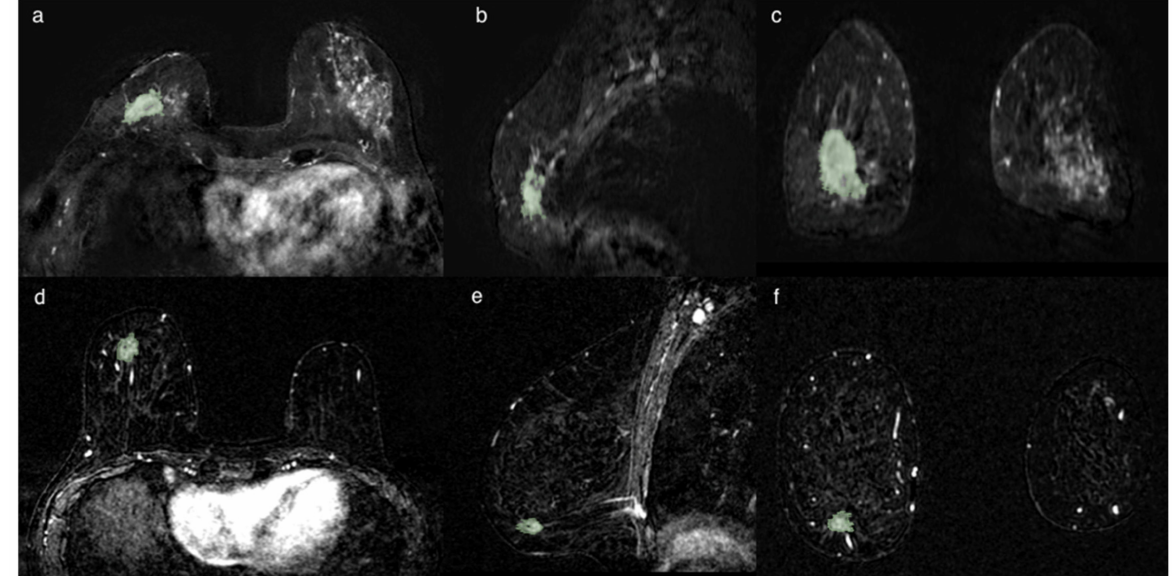
Figure 3. Two cases of breast cancer with positive and negative lymph node axillary involvement at definitive surgery, respectively. The first ( a – c ) represented by a 32 mm mass, in 56yo patient with TN CDI tumor characterized by spiculated margins, heterogeneous enhancement with a necrotic core and a signal/intensity curve type 3 at MRI exam. The second ( d – f ) is a 13 mm nodule, in a 61 yo patient, LUMINAL A CDI, characterized by irregular margins, heterogeneous enhance- ment and a signal/intensity curve type 3. The segmentation has been performed in the axial image ( a , d ), following the margins and including the spicule characterized by contrast-enhancement. The segmentation was then optimized in the sagittal ( b , e ) and coronal ( c , f ) planes, avoiding the darker part representing the necrosis and the